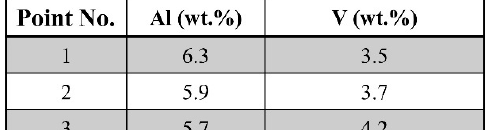
Figure 6. XRD spectra of Ti64 powder, as-built L-PBF, and PM sample.